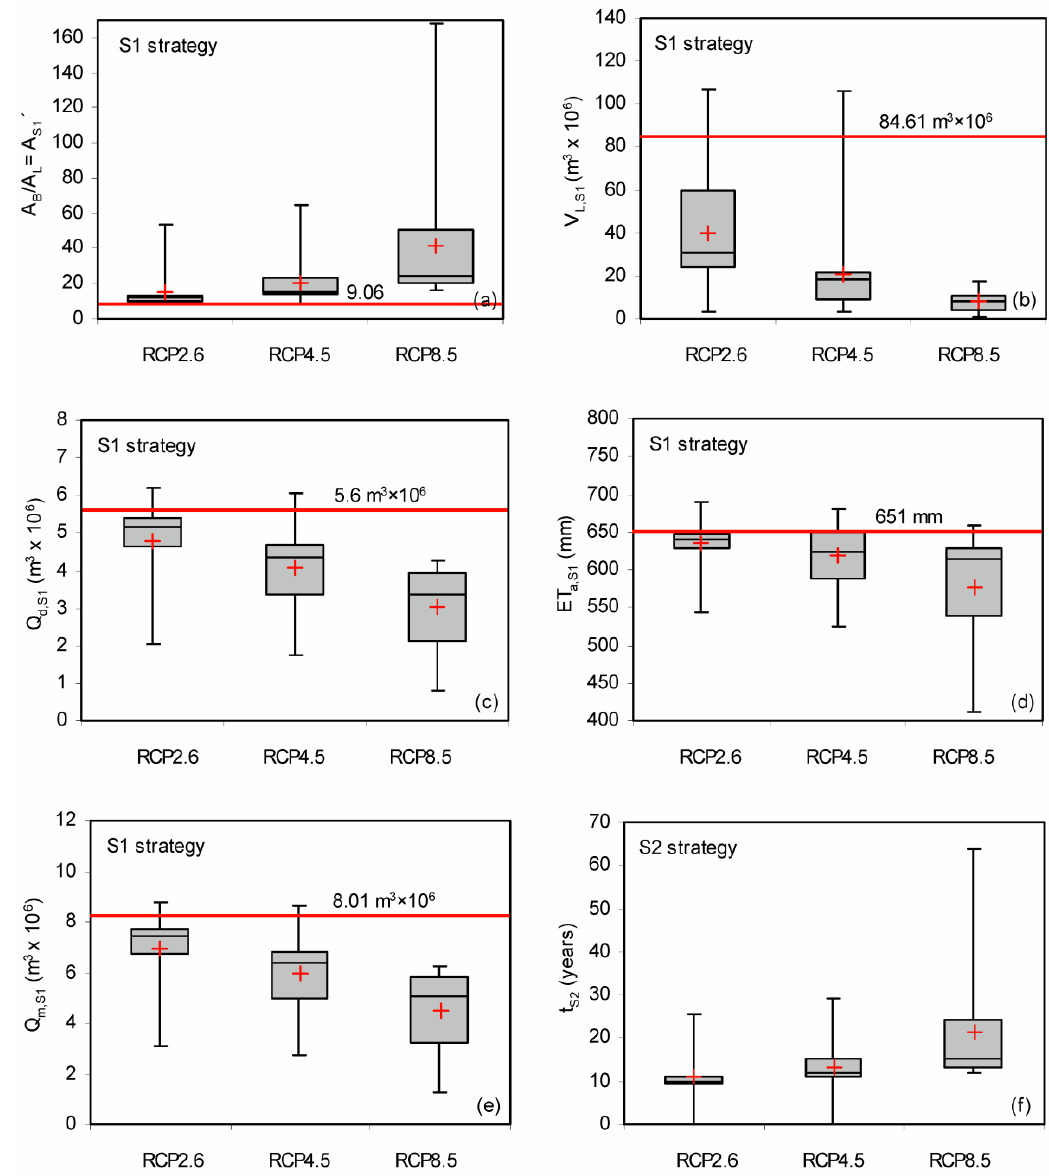
Figure 6. Box-whisker plots of mean annual values of ( a ) A B / A L = A S1 ΄ , ( b ) V L,S1 (m 3 × 10 6 ), ( c ) Q d,S1 (m 3 × 10 6 ), ( d ) ET a,S1 (mm), ( e ) Q m,S1 (m 3 × 10 6 ) according to S1 strategy, and ( f ) values of t S2 (years) according to S2 strategy. The red lines correspond to the mean annual values of the period 1/5/2012 – 31/4/2018.